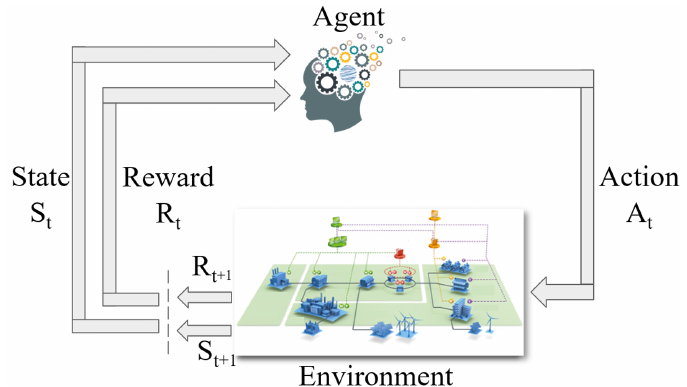
Figure 1. The agent-environment interaction in reinforcement